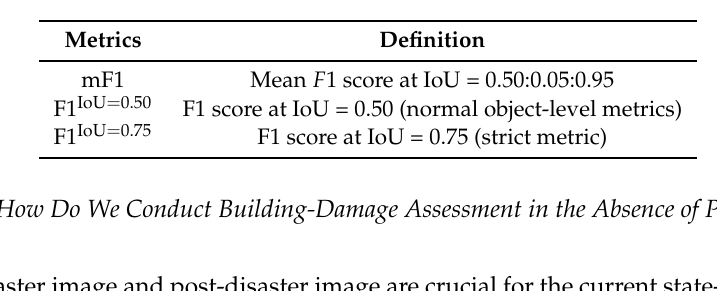
Table 1. F1 scores metrics under different IoU